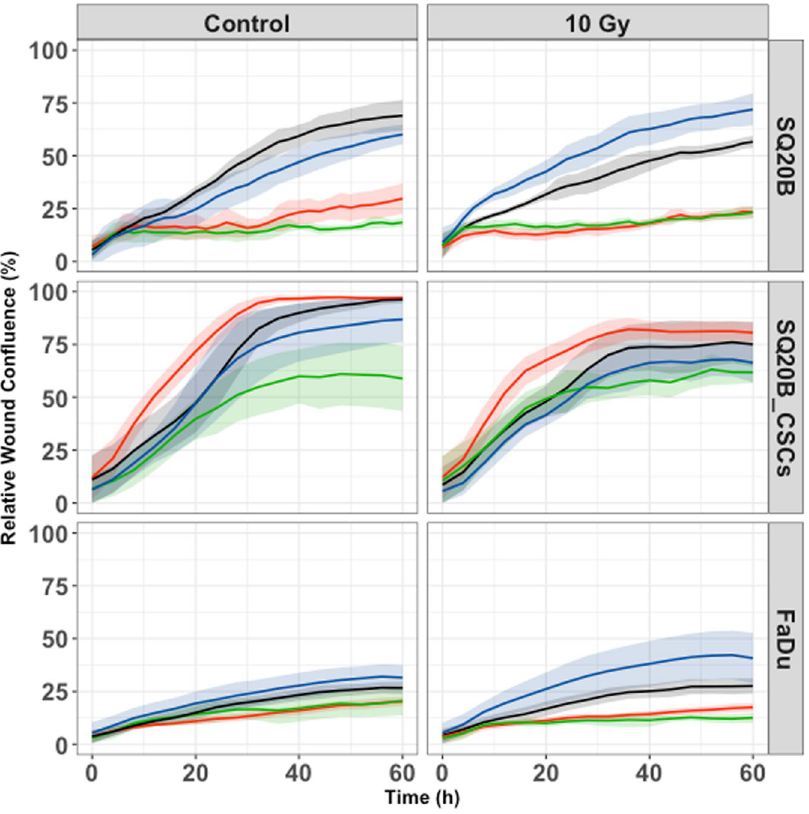
Figure 4. Cell invasion under each treatment condition, graphically represented by the mean invasion curves + / − standard deviation. Blue curve, control; black curve, pertuzumab 20 μ g/mL; red curve, cetuximab 5 nM; green curve, cetuximab 5 nM + pertuzumab 20 μ g/mL. Cell invasion was measured by an IncuCyte Zoom scratch wound analyser for each cell line under the following treatment conditions: control; cetuximab 5 nM; pertuzumab 20 μ g/mL; cetuximab 5 nM + pertuzumab 20 μ g/mL; 10 Gy; 10 Gy + cetuximab 5 nM; 10 Gy + pertuzumab 20 μ g/mL; 10 Gy + cetuximab 5 nM + pertuzumab 20 μ g/mL. Reduced Matrigel (dilution 1/10) was set into each wound. Each experiment was performed in